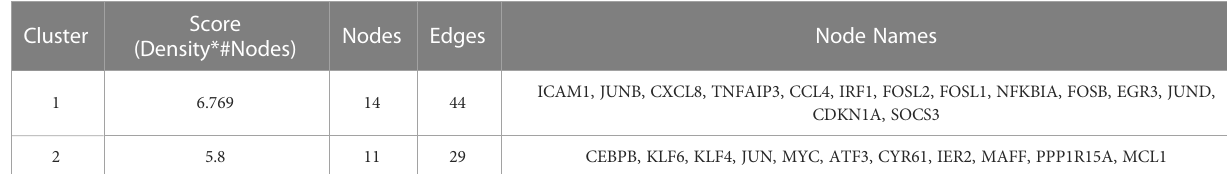
TABLE 2 Data downloaded from STRING were processed using molecular complex detection technology to further mine gene clusters.